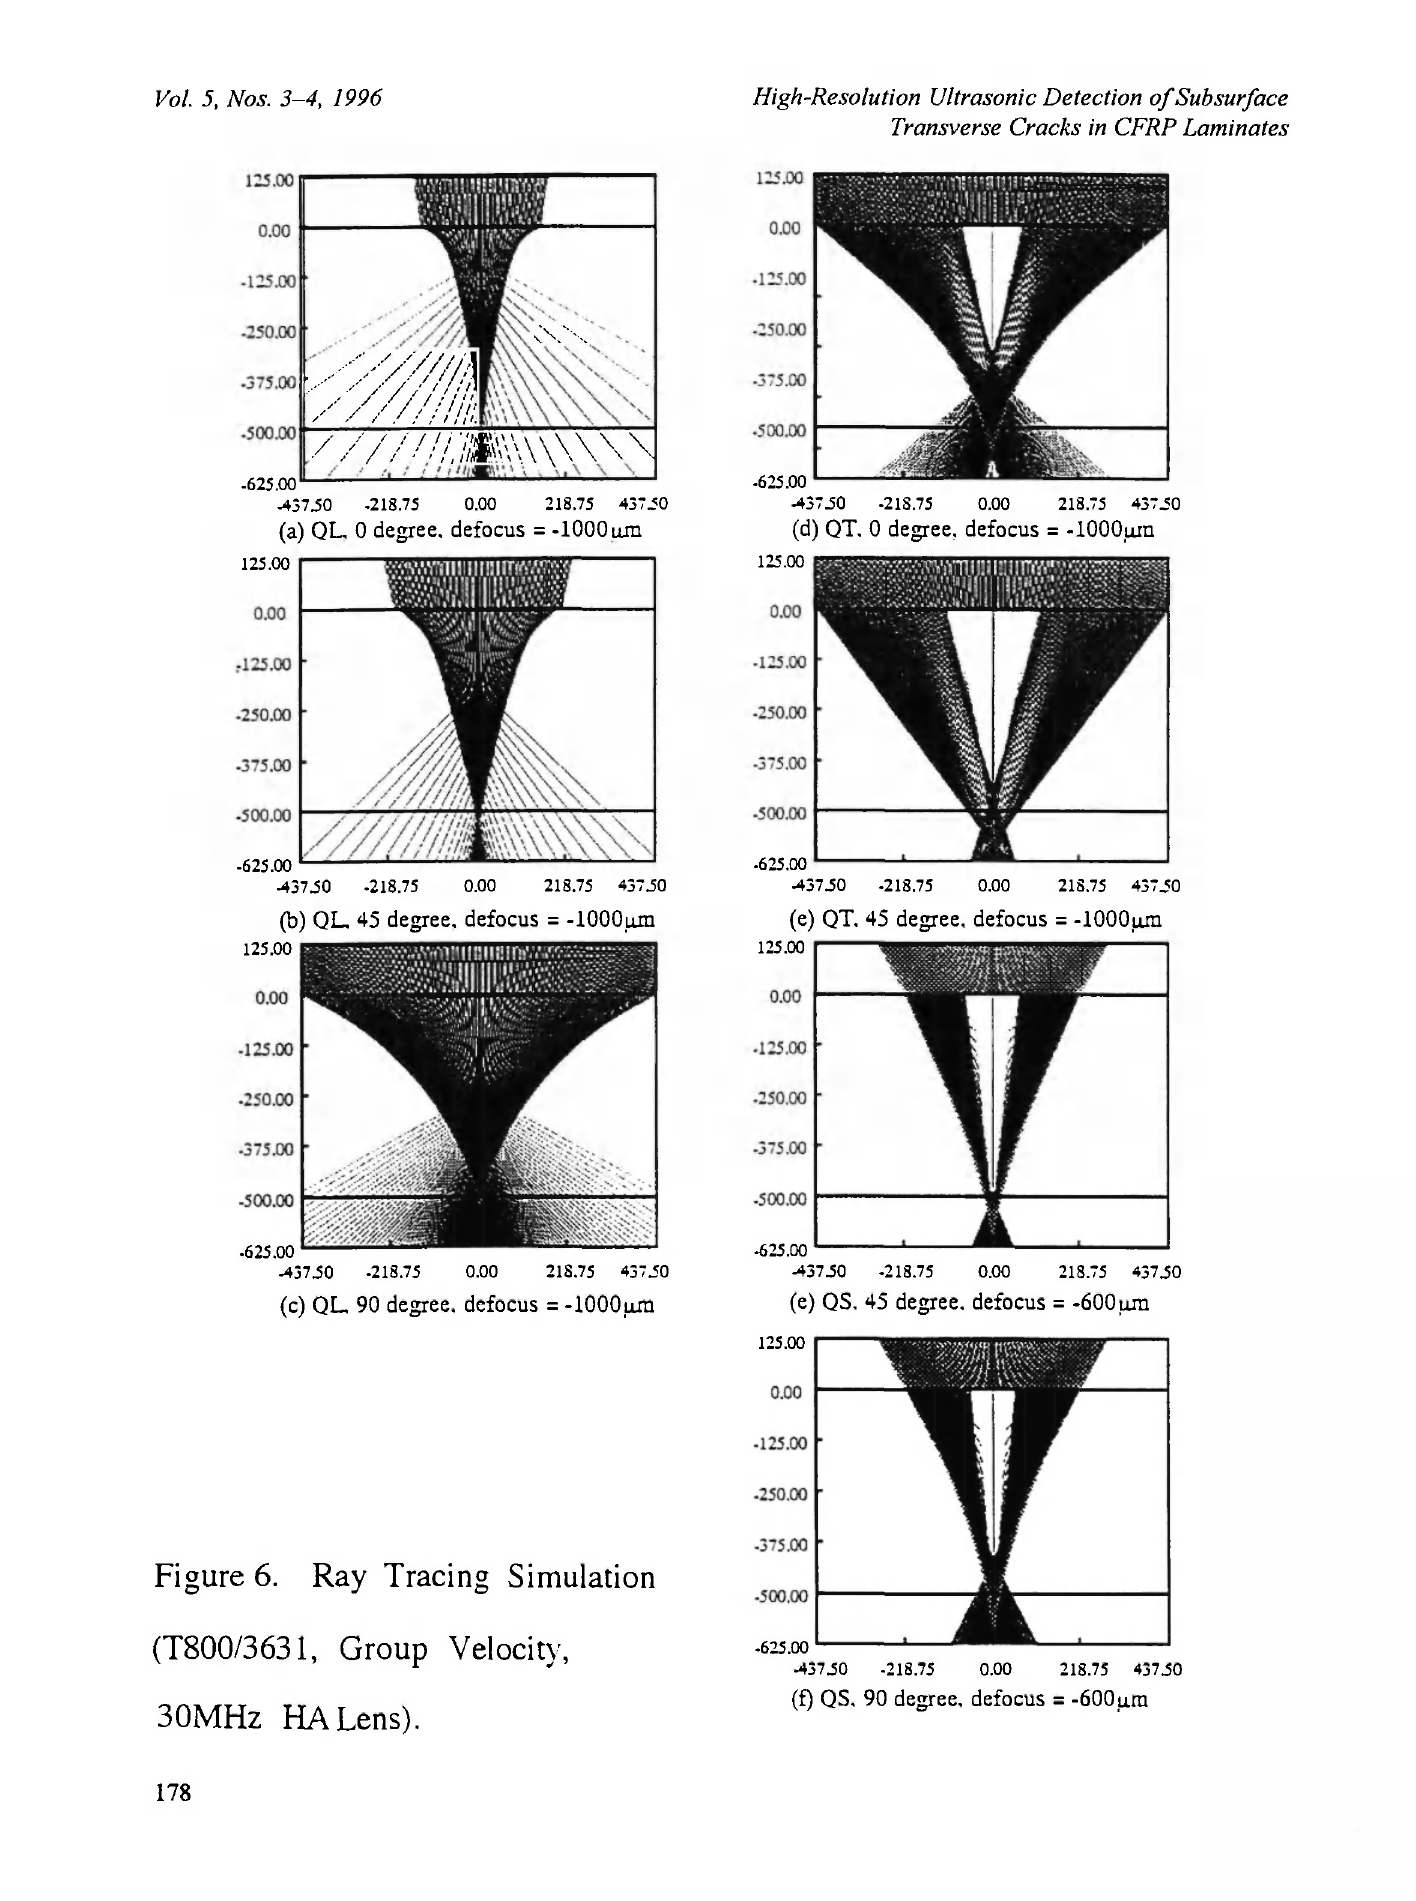
Figure 6. Ray Tracing Simulation (T800/3631, Group Velocity, 30MHz HA